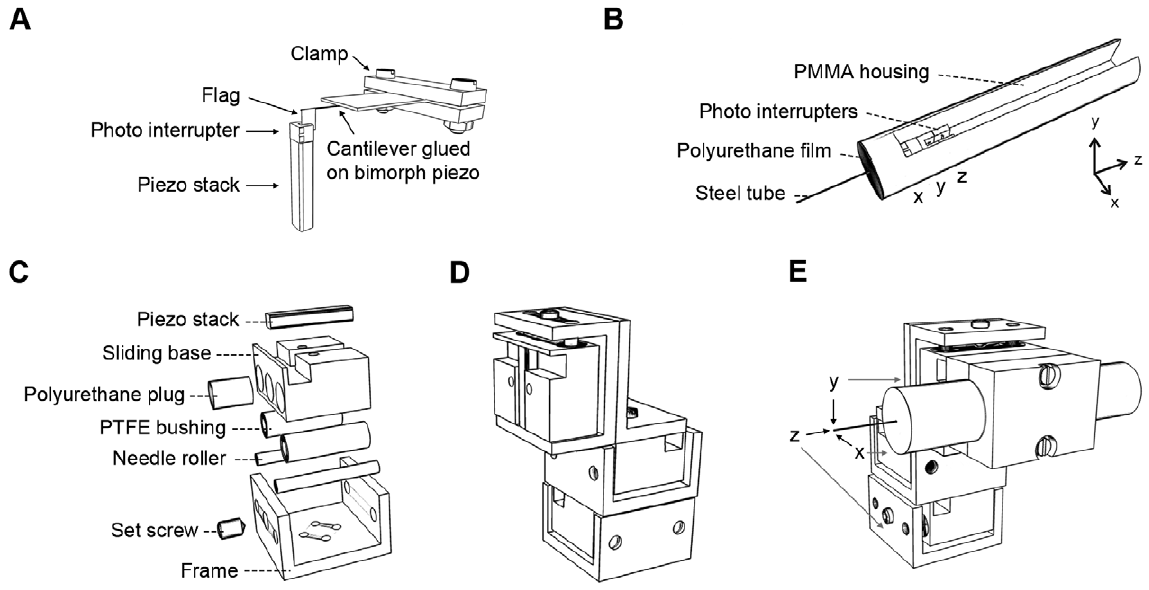
Figure 1. Schematic overview of the active stabilization system. A, 1D stabilization system prototype. B, 3D movement sensor prototype (diameter 12 mm and length 55 mm); axis definitions as used throughout the study. C, Piezo-actuator prototype. D, Three axis actuator assembly (25x37x56 mm 3 ). E, Schematics of the stabilization system test setup with three-axis actuator and 3D movement sensor.